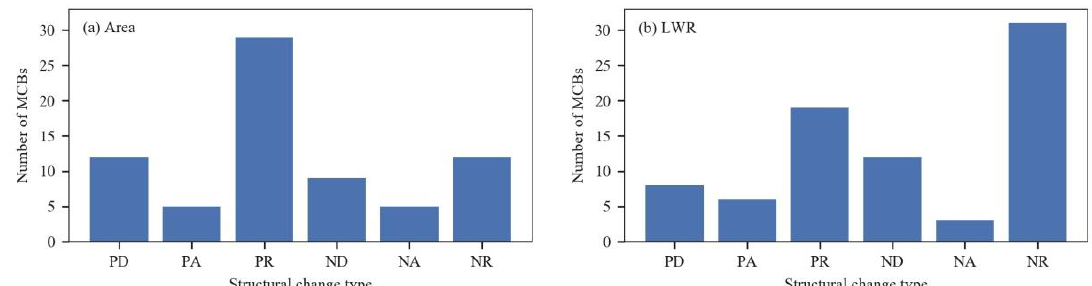
Figure 13. ( a ) Frequency of structural changes (FSC) with distance to TGD. ( b ) The total amount of sand mining in the downstream of TGD.